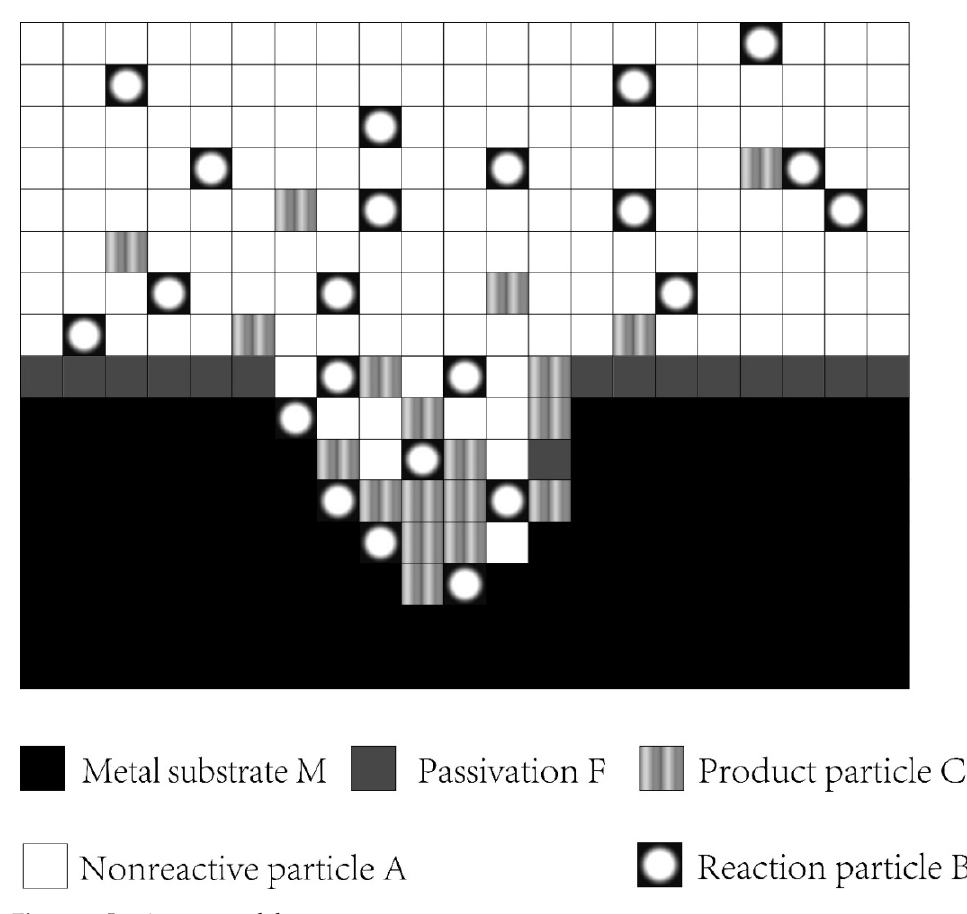
Figure 2. Lattice gas model space.